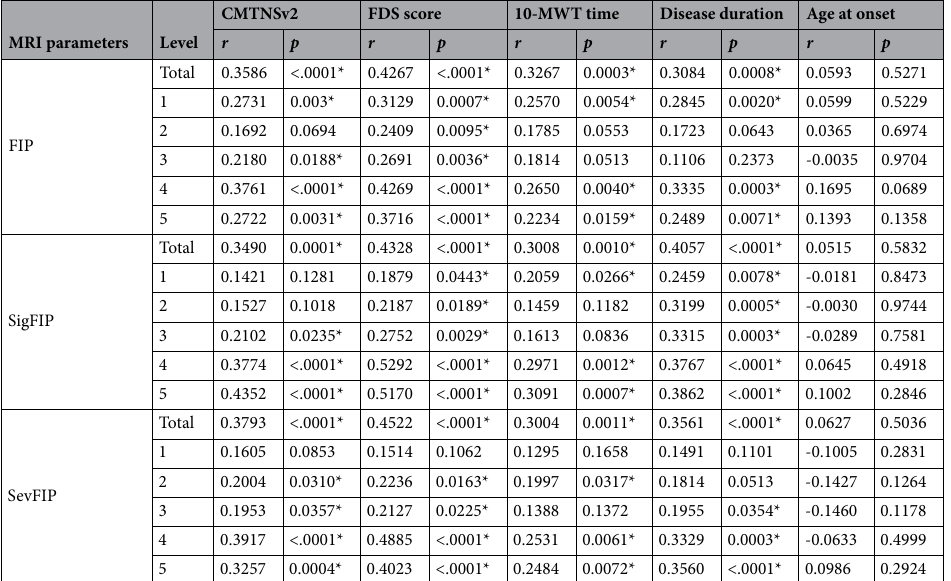
Table 2. Correlation analysis between MRI and clinical parameters in patients with Charcot-Marie-Tooth disease type 1A. *Indicates statistical significance. r Spearman’s correlation coefficient; p p -value; FIP fat infiltration proportion; Sig FIP significant fat infiltration proportion; SevFIP severe fat infiltration proportion; CMTNSv2 Charcot-Marie-Tooth Neuropathy Score version 2; FDS Functional Disability Scale; 10-WMT 10-m walk